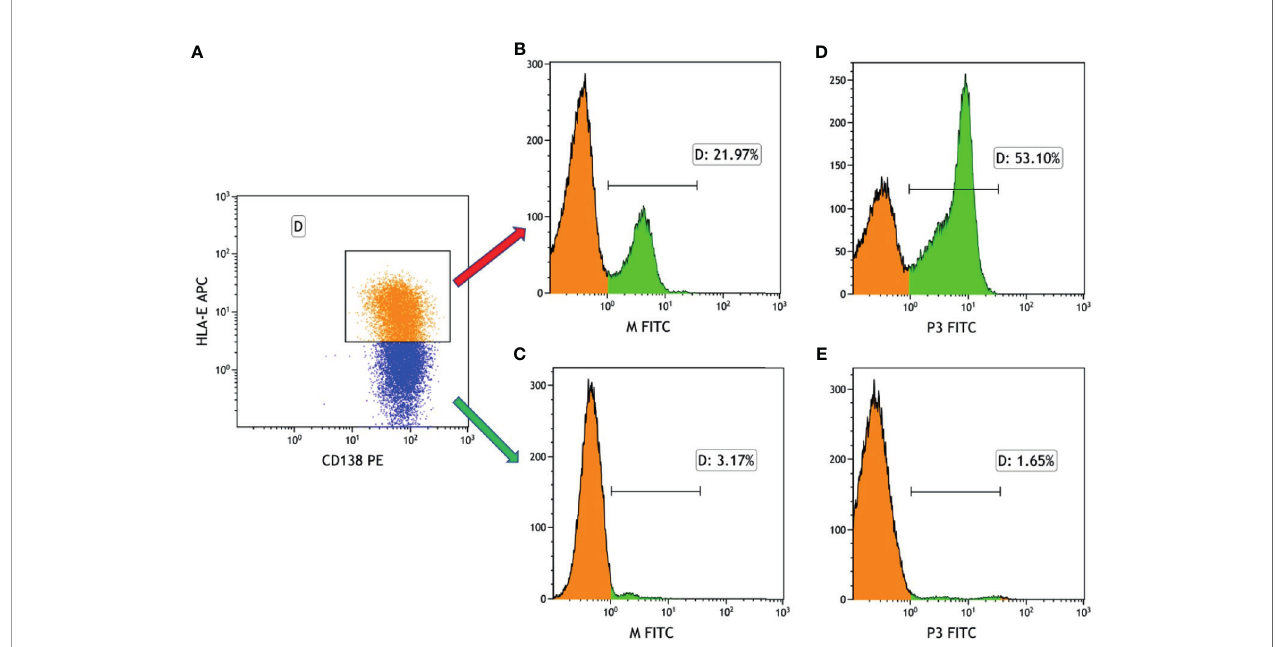
FIGURE 3 | The binding frequency of HLA-E-targeted binding peptides to the bone marrow cells from the patients with NDMM. (A) Myeloma cells were divided into HLA-E+ cells and HLA-E- cells. (B) The binding af fi nity of peptide M to HLA-E positive myeloma cells was 21.97%. (C) The af fi nity of peptide M to HLA-E negative myeloma cells was 3.17%. (D) The binding af fi nity of peptide P3 to HLA-E positive myeloma cells was 53.10%. (E) The binding af fi nity of peptide M to HLA-E negative myeloma cells was